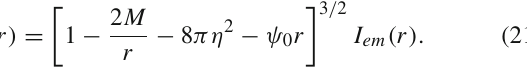
rings (which are the green lines in Fig. 3), it does not only intersect with the opposite side of the disk, but also with the front side. Those rays will pick up the additional brightness twice. In view of this, the total observed intensity should be regarded as a sum of those intensities from each intersection. So,